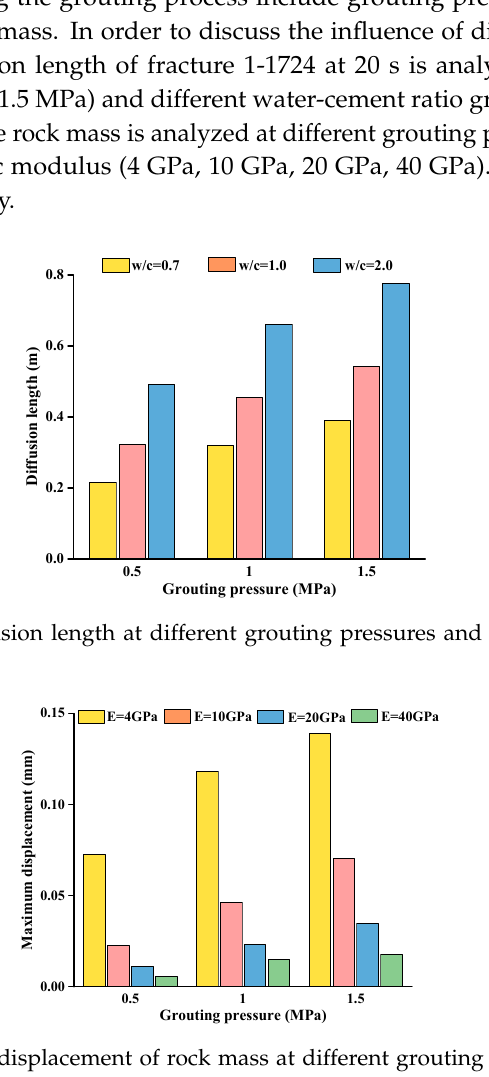
Figure 15. The maximum displacement of rock mass at different grouting pressures and different elastic modulus.